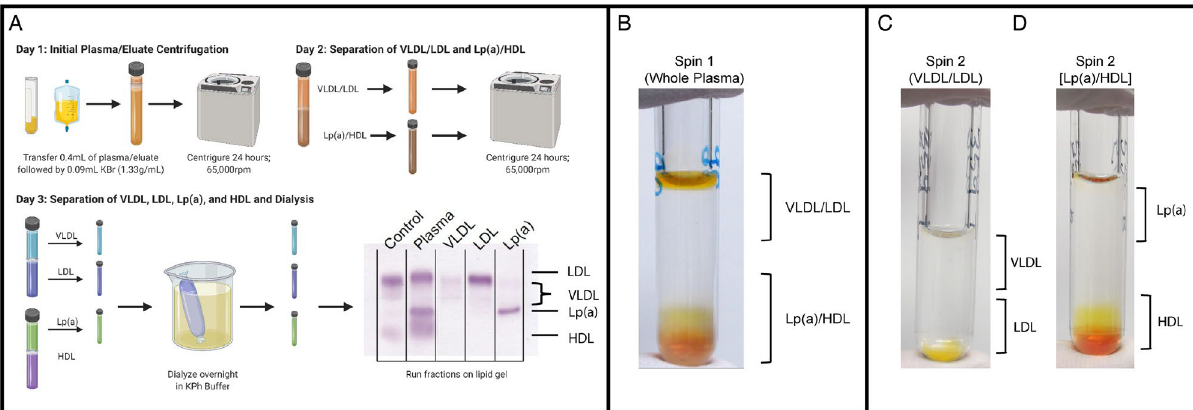
Figure 1. Small-volume lipoprotein isolation workflow. ( A ) Workflow for small-volume isolation of Lp(a), VLDL and LDL from whole plasma. HDL is isolated using a separate ultracentrifugation method described in Materials and Methods but is included in this diagram for visualization. ( B ) Example image of lipoprotein separation following the first ultra-centrifugation spin. VLDL/LDL fractions are found at the top of the suspension while Lp(a)/HDL localize to the bottom. ( C ) Example image of the separation of VLDL and LDL following the second ultra-centrifugation spin. ( D) Example image of the separation of Lp(a) and